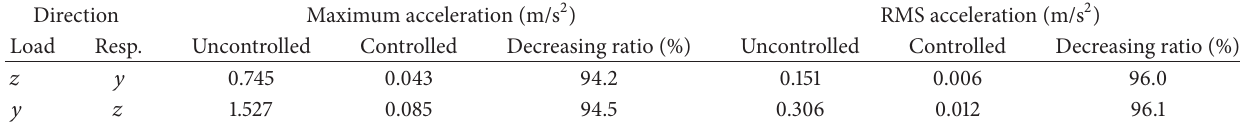
Table 9: Directional results for California